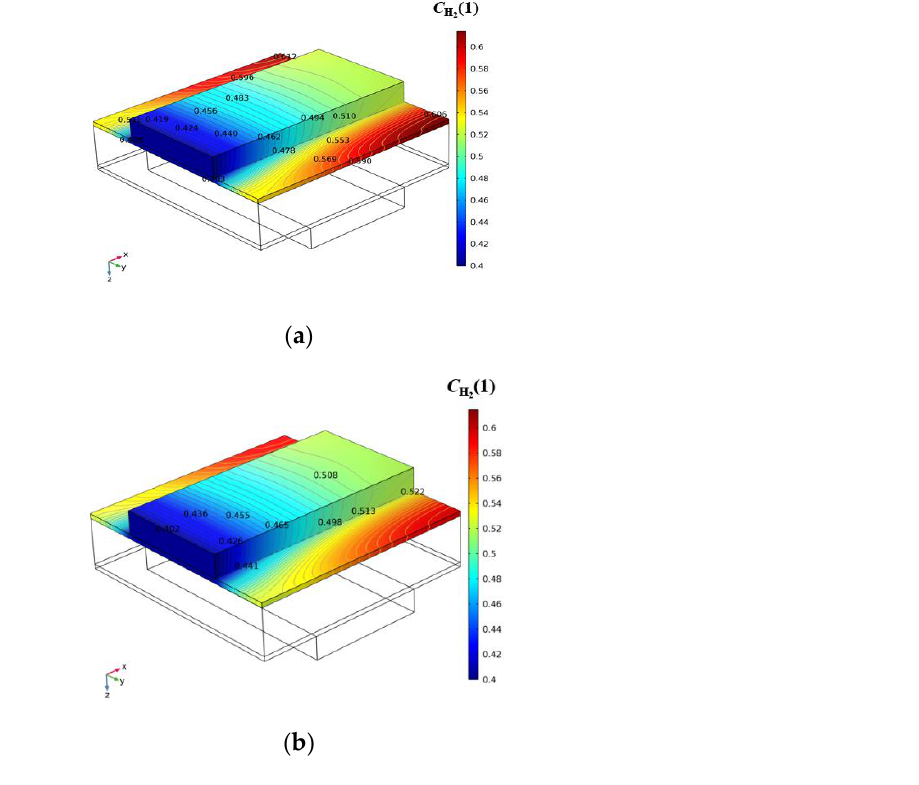
Figure 4. Hydrogen mole fraction distribution in the fuel channel and the composite cathode at different operating pressures: ( a ) 1 atm; ( b ) 10 atm.